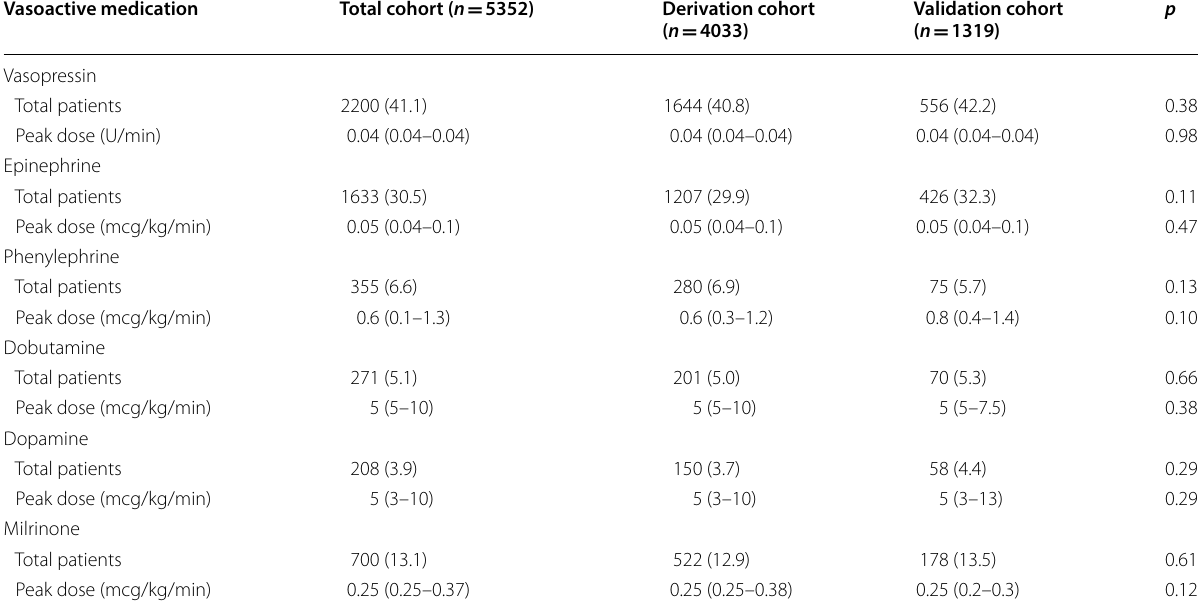
Total (percentage) or median (interquartile range)